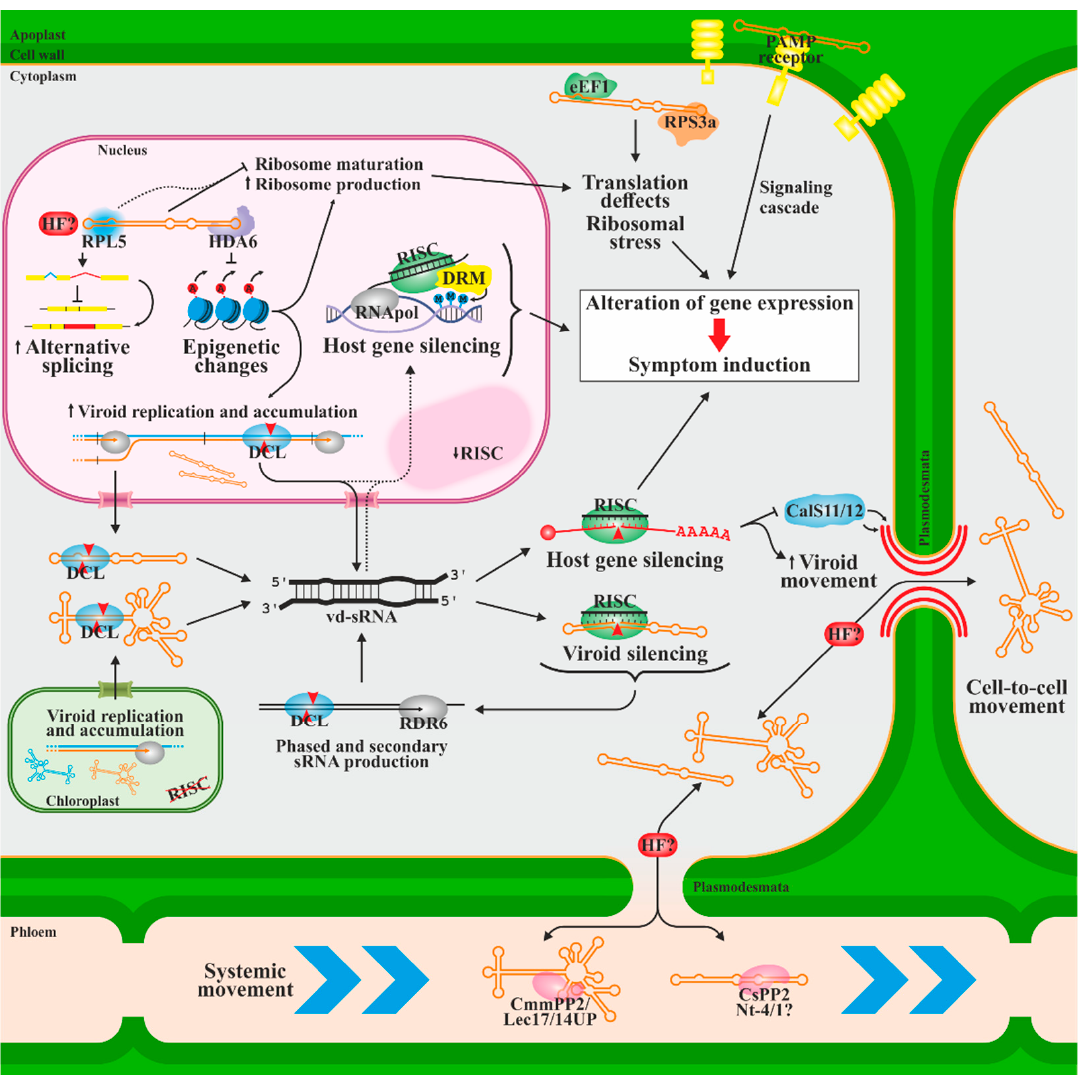
Figure 3. Proposed mechanisms of host defense responses, viroid pathogenesis and intercellular movement. Plant RNAi response is responsible for much of the viroid symptoms. dsRNA replicative intermediates and the cytoplasmic passage of viroids triggers the production of vd-sRNAs in plant cells. vd-sRNA-loaded RISC targets viroids and inhibits the expression of host genes containing complementary sequences post-transcriptionally by mRNA degradation and translation inhibition and possibly transcriptionally via RNA-directed DNA methylation. RDRs may transform sRNA fragments into additional DCL and RISC substrates. Viroid may also be recognized by cell membrane PAMP receptors stimulating plant innate immunity, resulting in the alteration of host gene expression. Additional interactions with proteins and host factors are responsible for global epigenetic changes, alternative splicing and interference with translational machinery, thus, are also involved in the development of symptoms. Viroids use plasmodesmata for proximal movement and phloem for systemic transport, likely interacting with specific (and in some cases unknown) host factors. RNAi response genes can increase intercellular movement. CalS11/CalS12, callose synthase 11 and 12, respectively; CmmPP2/Lec17/14UP, Cucumis melo phloem protein 2, phloem lectin 17 and uncharac- terized protein of 14 kDa, respectively; DCL, Dicer-like protein; DRM, domains rearranged methylase; eEF1, eukaryotic elongation factor 1; HDA6, histone deacetylase; HF?, unknown host factor; Nt-4/1, Nicotiana tabacum 4/1 protein; PAMP, pathogen-associated molecular pattern; RISC, RNA-induced silencing complex; RDR6, RNA-dependent RNA polymerase 6; RNApol, RNA polymerase; RPL5, ribosomal protein L5; RPS3a, ribosomal protein S3a; and vd-sRNA, viroid-derived small